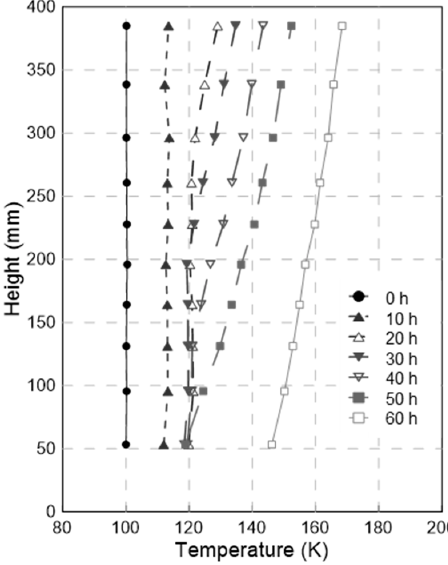
Figure 8. Time dependent liquid nitrogen weight.